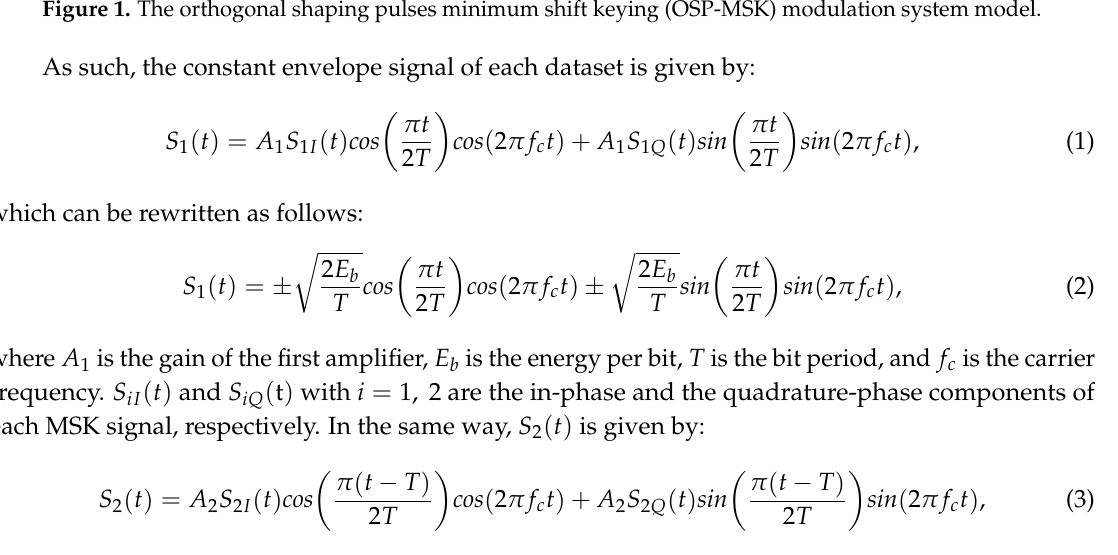
Figure 1. The orthogonal shaping pulses minimum shift keying (OSP-MSK) modulation system model.